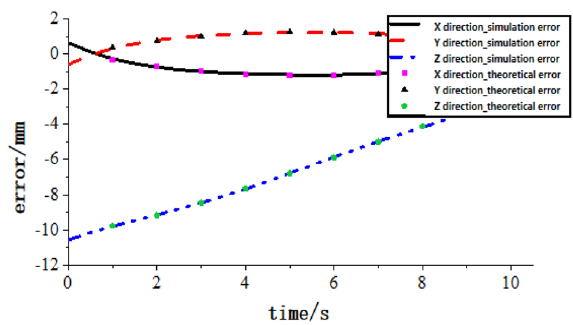
Figure 17. Position error comparison of ADAMS-numerical